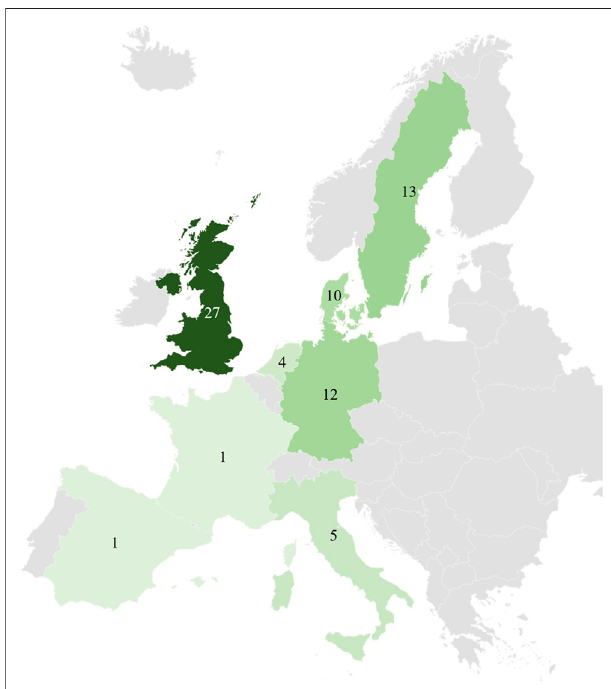
FIGURE 7 | Map preferential locations to synthesize waxes in Europe from biomethane plants.